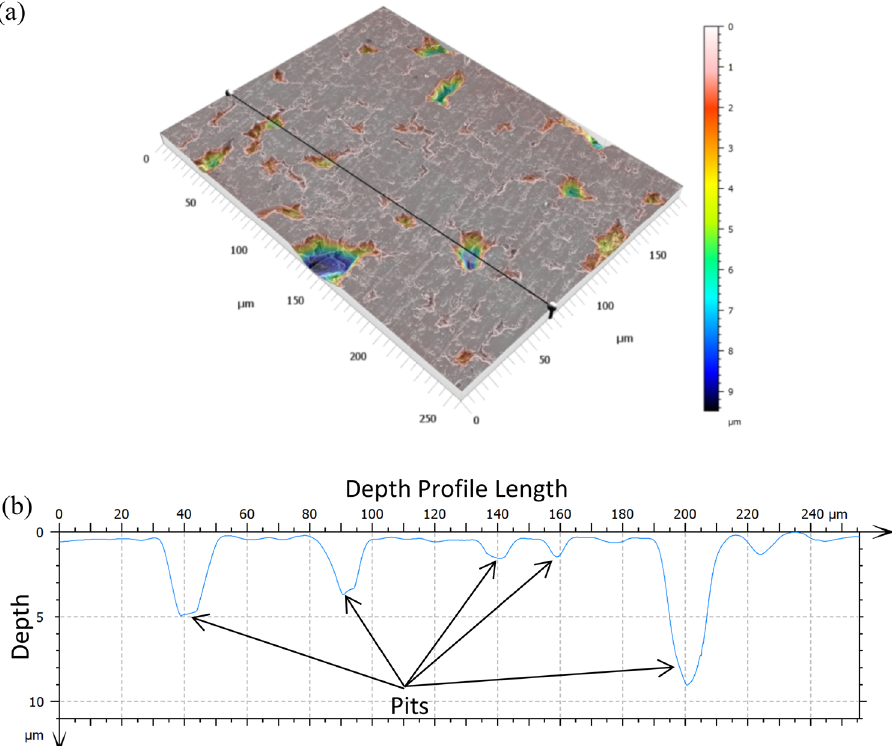
Figure 5. 3D reconstruction of a Type 2 surface from a 20 W cm −2 , 1 h experiment created using MountainsSEM ( a ). The line across the image designates where the depth profile ( b ) was taken. The additional pitting from erosion has caused the surface area to slightly increase compared to a surface with normal leaching features. Pits appear to be between 1 and 10 microns in